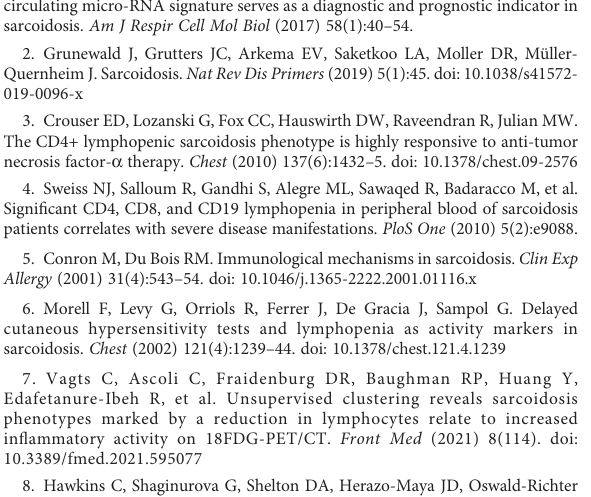
SUPPLEMENTARY FIGURE 4 Differential expression analysis in the ACCESS and UCSF (GSE19314) cohorts. (A, B) Volcano plots demonstrating differentially expressed genes between sarcoidosis cases and controls within WGCNA gene modules found to be signi fi cantly associated with disease (blue, brown, cyan, greenyellow, and magenta) in the ACCESS cohort (A) and the UCSF cohort (B) . Signi fi cance was determined based on false discovery rate <10% (Benjamini-Hochberg adjusted [BH-adj] p-value < 0.1) utilizing the moderated t-test in the limma R-package. Horizontal gold solid line denotes BH-adj p-value of 0.1, vertical gold solid lines denote log 2 -fold